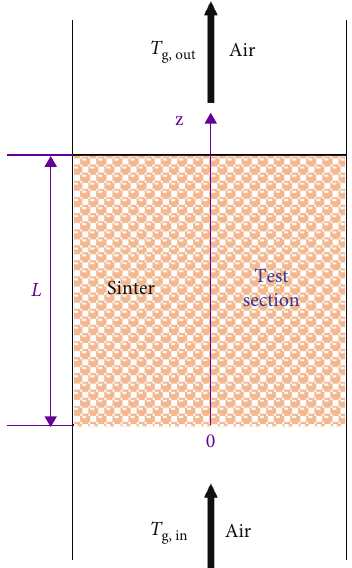
and speci fi c heat c p of the sinter at di ff erent temperatures. s s